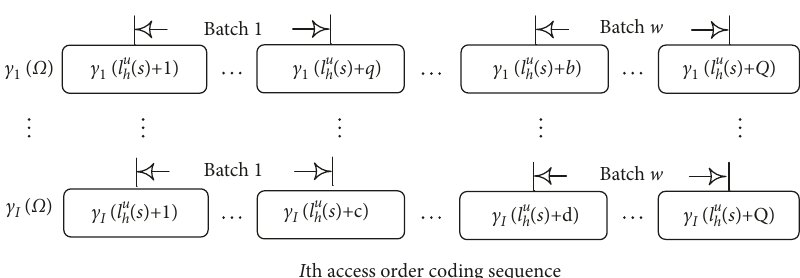
Figure 3: A diagram of the access order coding sequence population.